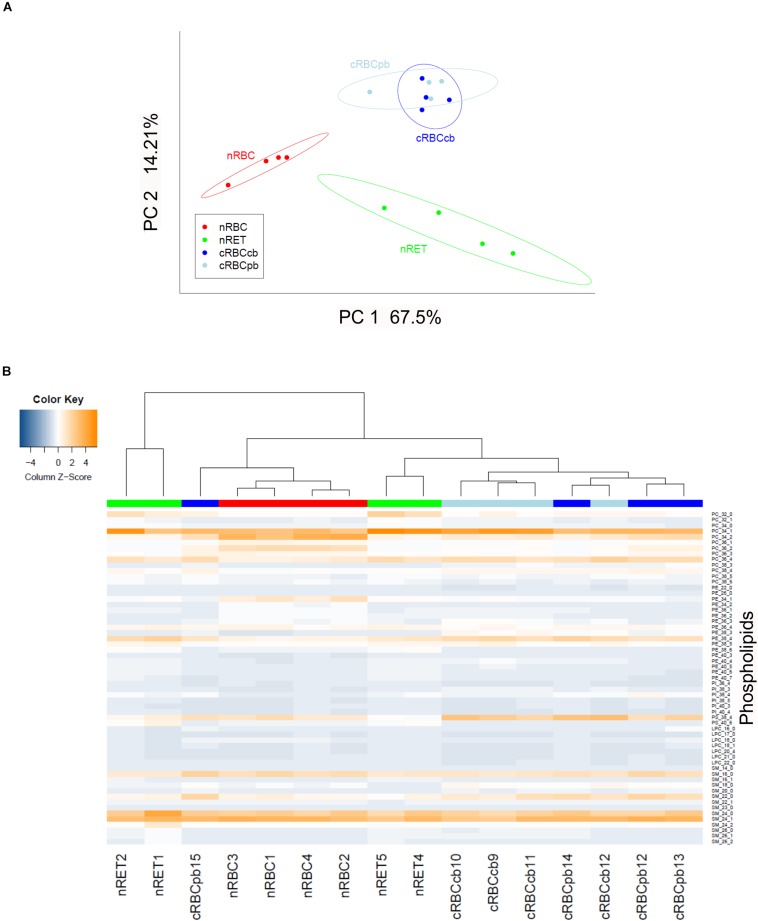
Statistical evaluation of lipidomics data after lipid subtype analysis. (A) Principle component analysis showing clustering of nRETs, nRBCs, cRBCpb, and cRBCcb (n = 4 each). The ellipses show the 95% confidence interval. The first two principal components (PC1 and PC2) covered 81.71% of the data variability. (B) Heat map with hierarchical clustering analysis. Color bars mark the different sources (red: nRBCs, green: nRETs, dark blue: cRBCpb, light blue: cRBCcb). To standardize the data for the heatmap, z-scores over the samples were calculated by subtracting the sample mean and dividing over its standard deviation. Coloring is helping to easily visualize whole data, where blue tones show lower values and orange tones higher values. The reader can immediately recognize data patterns as well as similarities/differences between samples. The color key of the heat map shows the column z-scores. Cell types were clustered with the complete linkage agglomerative hierarchical clustering method on Euclidean distances. We used this statistical method to group the samples according to their phospholipid profiles.